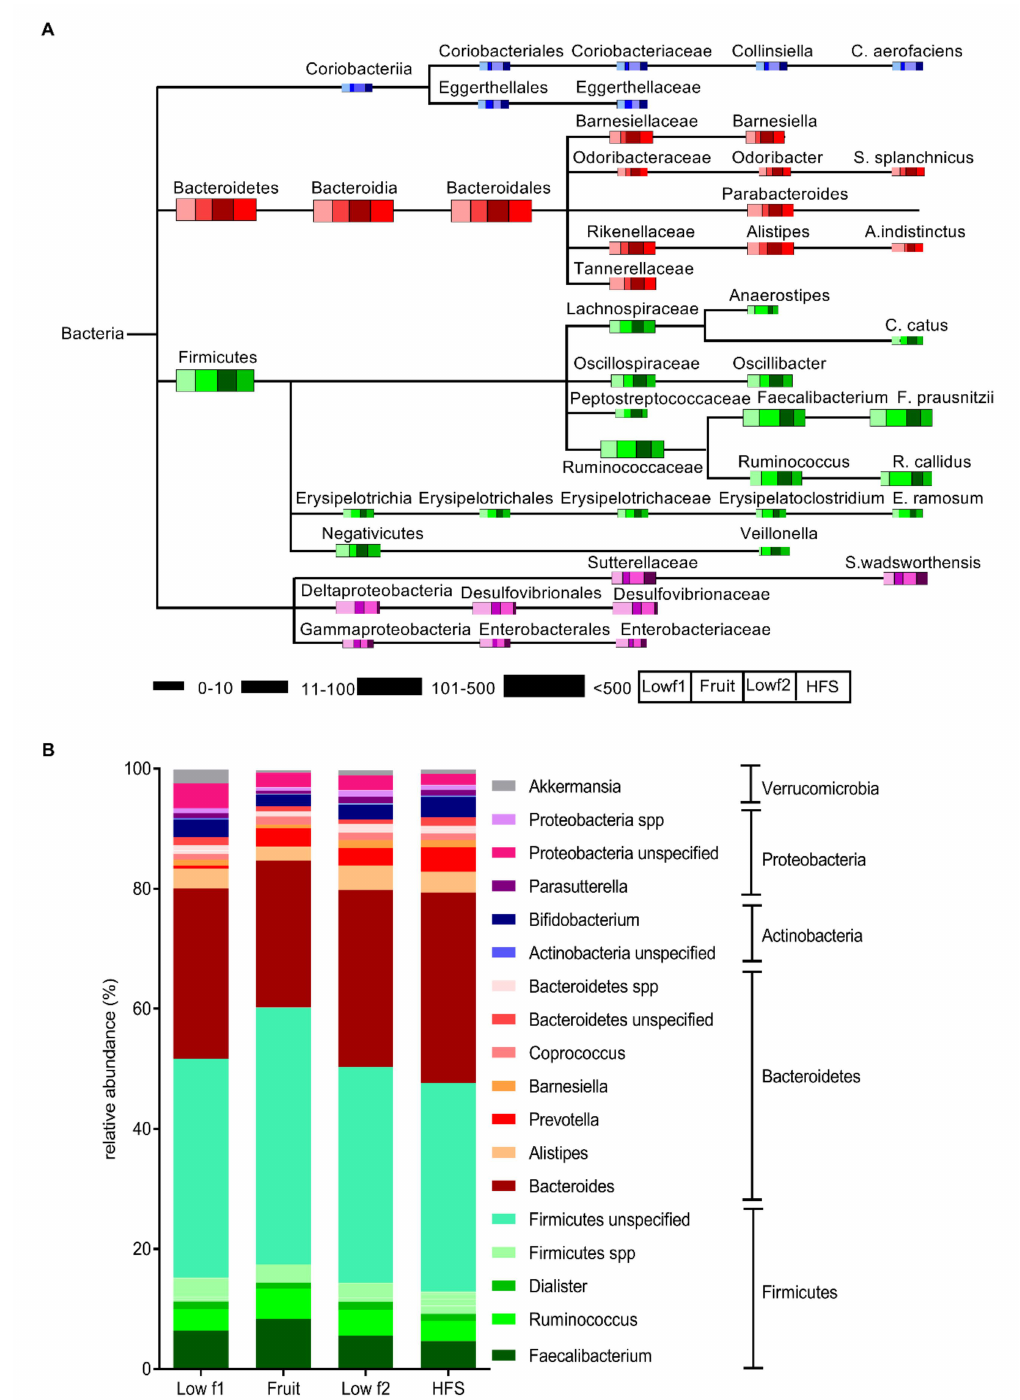
Figure 2. E ff ects of di ff erent fructose diets on the composition of the gut microbiome. ( A ) Composition of bacterial communities that changed among the di ff erent fructose diets. The schematic dendogram was constructed from 16S rRNA sequencing analysis results. Size of the bars represents the abundances of the bacterial taxa. Di ff erent phyla were shaded by di ff erent colors: blue, Actinobacteria; red, Bacteroidetes; green, Firmicutes; purple, Proteobacteria. ( B ) Distribution of the relative abundances at phylum and genus level between the di ff erent fructose